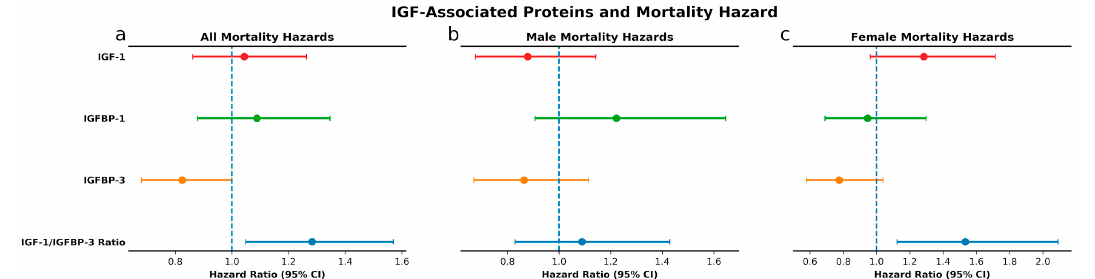
Figure 2. IGF-associated proteins and mortality hazard. Sex and age-adjusted survival hazards for combined cohort ( a ) and age-adjusted survival hazard for males ( b ) and females ( c ) with high levels of IGF-associated proteins as compared to individuals with low levels.